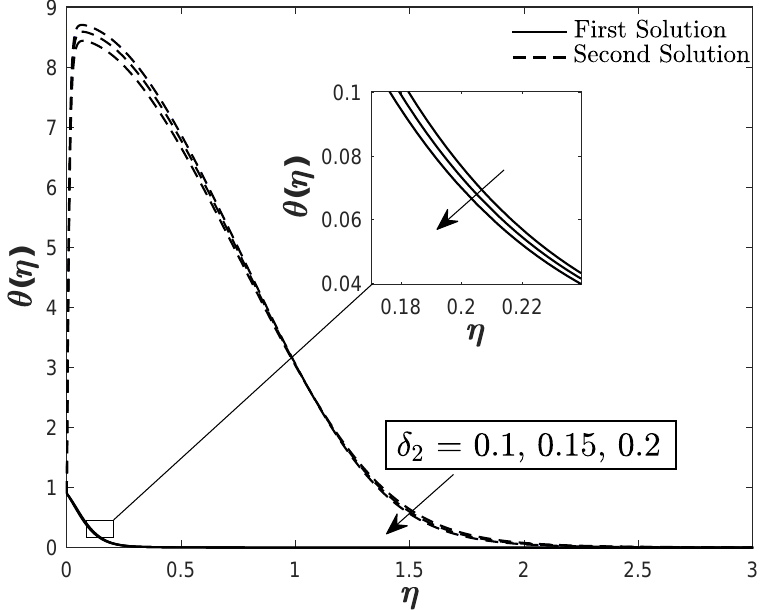
Figure 10. Effect of solutal stratification δ 2 on the temperature profile.